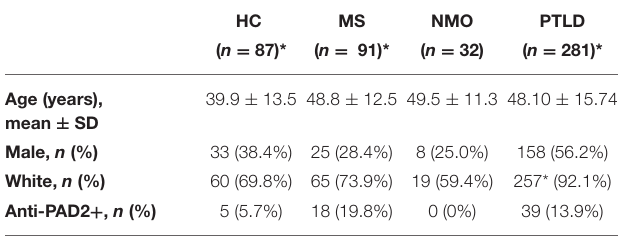
TABLE 1 | Demographics and anti-PAD2